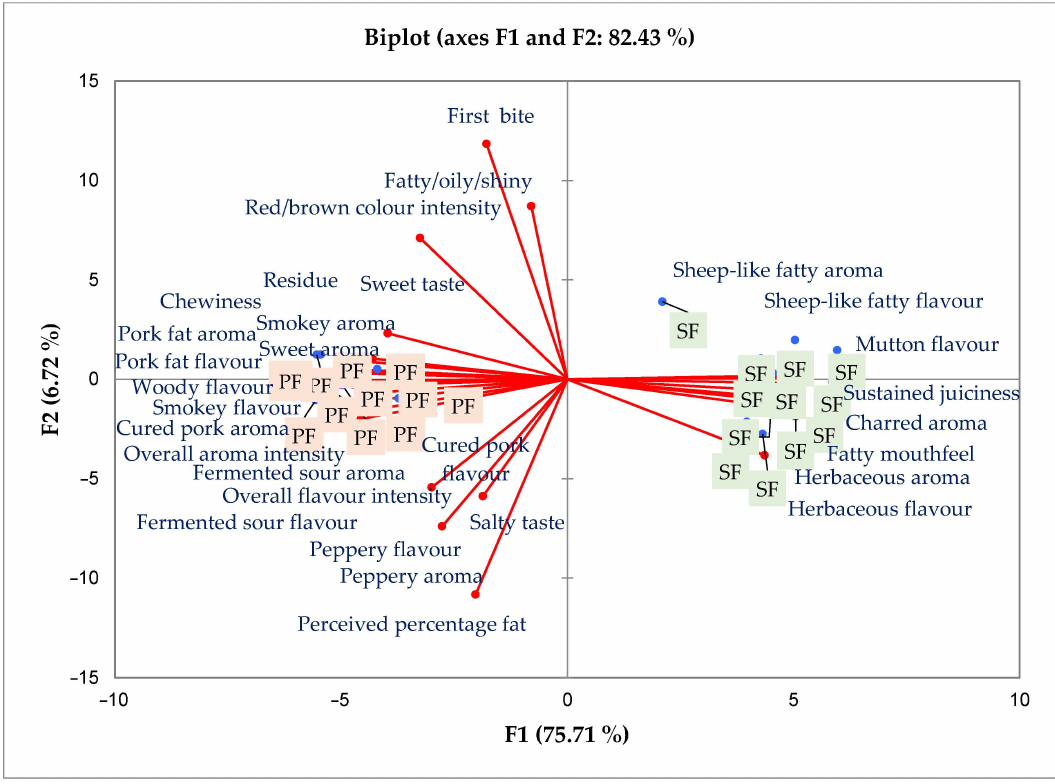
Figure 1. Principal component analysis for the sensory attributes of cabanossi made with either pork backfat (PF) or fat-tailed sheep fat